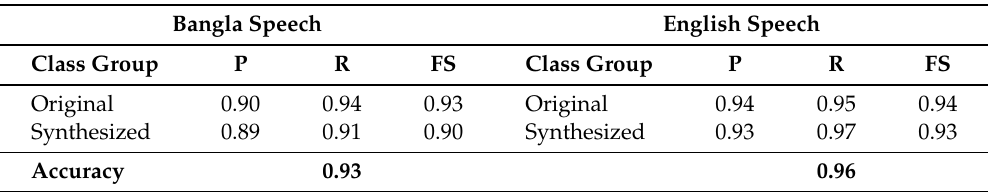
Table 3. Classification Results of Type of Audio for Bangla and English Speech Precision (P), Recall (R), and F1-score (FS) using the SCAE-MLELMs model.